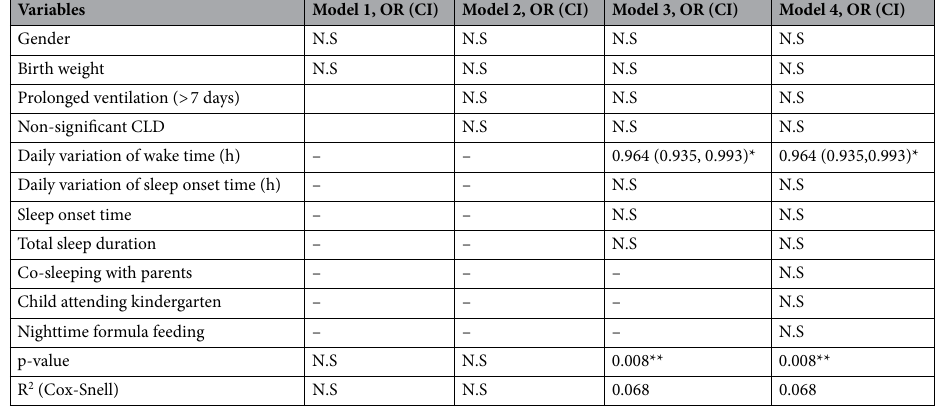
Table 5. Logistic regression analysis of DQ scores of toddlers with birth profiles, respiratory complications, sleep variables, and sleep arrangements (OR, 95% CI, **p < 0.01,* p < 0.05). RDS respiratory distress syndrome, Non-significant CLD non-significant chronic lung disease, N.S. not